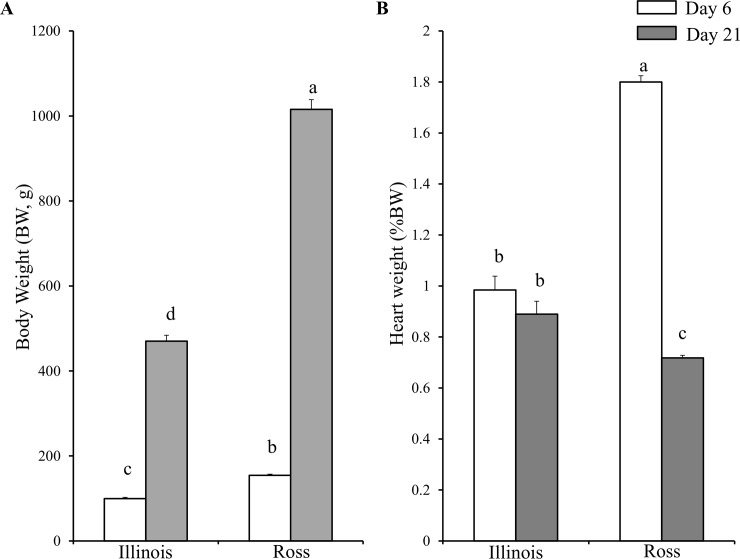
Ross broilers showed faster body growth but relatively slower cardiac development than Illinois broilers.(A) Body weight of two broiler lines at day 6 and 21. (B) Normalized heart weight of two broiler lines at day 6 and 21. Each bar represents Mean±SEM. Different letters (a-d) represent significant differences among different groups.